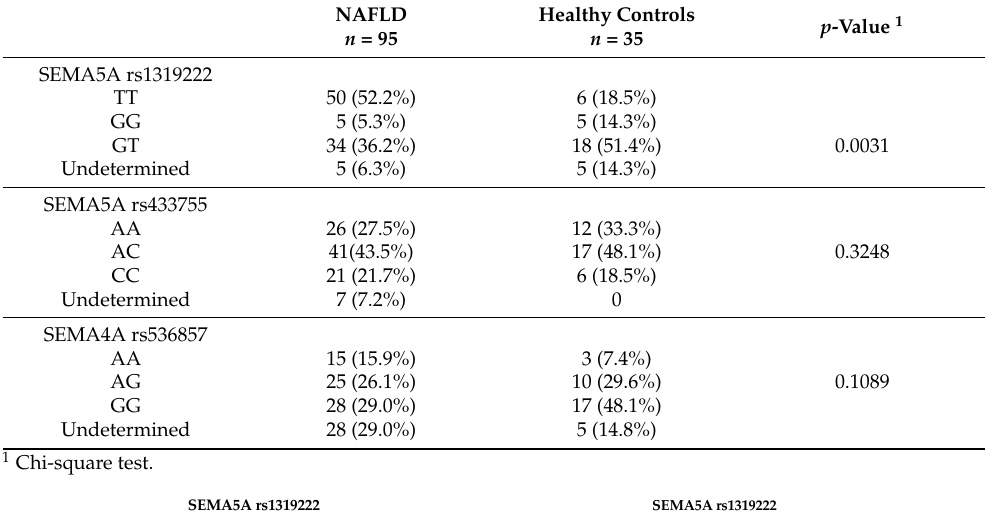
Table 2. Distribution of genotypes and allele frequencies in SEMA5A-rs1319222, -rs433755 and SEMA4A-rs536857 in patients with NAFLD and in healthy controls.